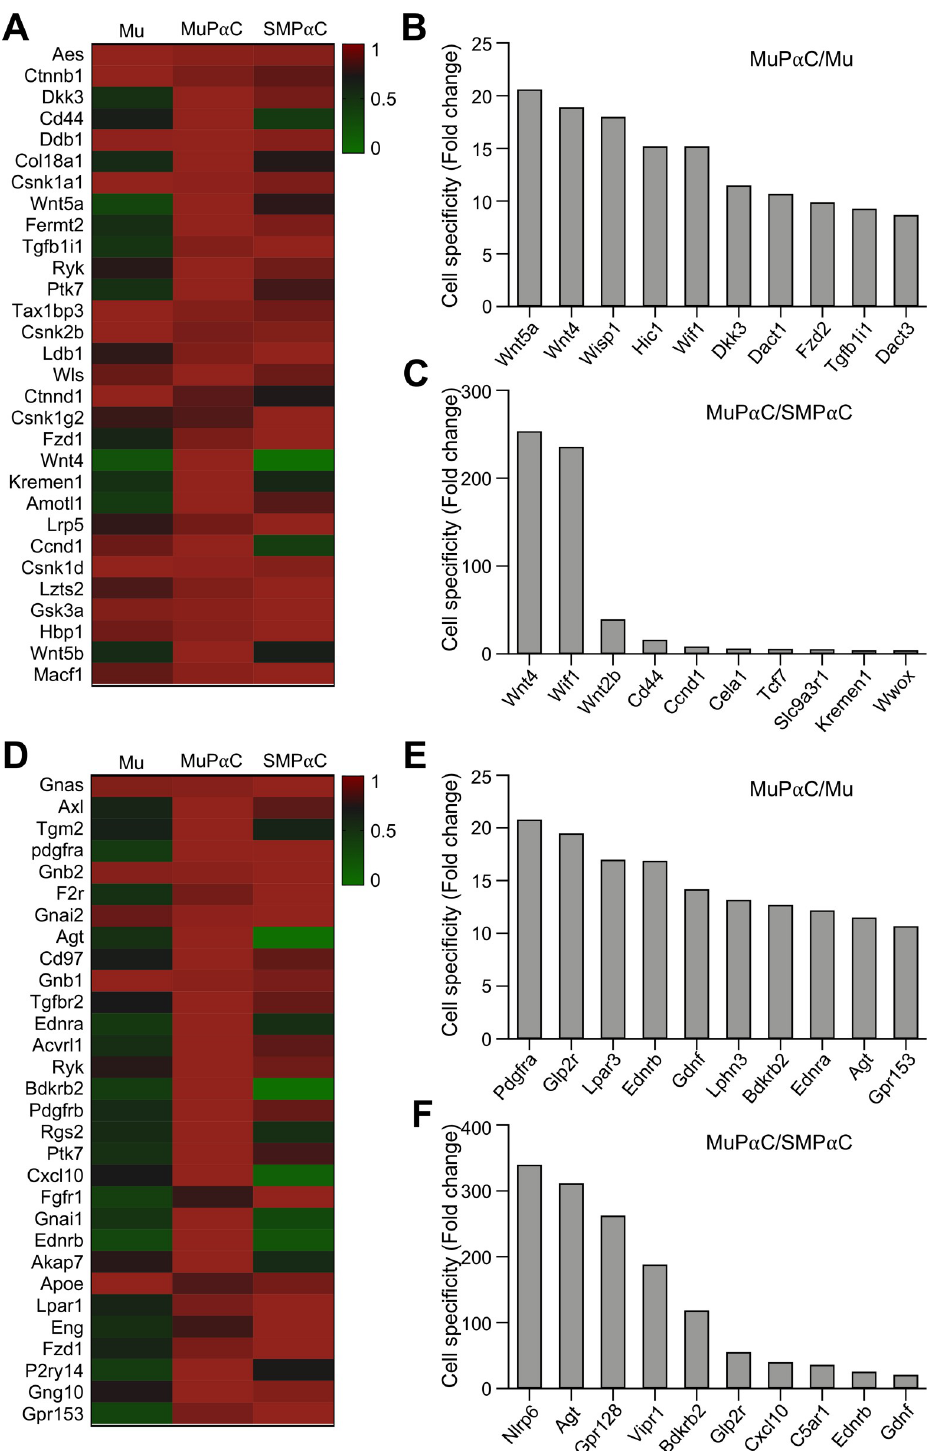
Fig 5. Identification of the cell signaling genes, receptors and receptor binding proteins predominantly expressed in colonic MuP α C. A : A heat map of the cell signaling genes enriched in MuP α C compared to mucosal tissue (Mu) and smooth muscle PDGFR α + cells (SMP α C). B : MuP α C-specific cell signaling genes compared to Mu. C : MuP α C- specific cell signaling genes compared to SMP α C. Sorted by MuP α C/Mu, cut off 10 fold MuP α C in MuP α C/Mu; sorted by MuP α C/SMP α C, cut off 10 fold MuP α C and 0 fold SMP α C in MuP α C/SMP α C. D : A heat map of the